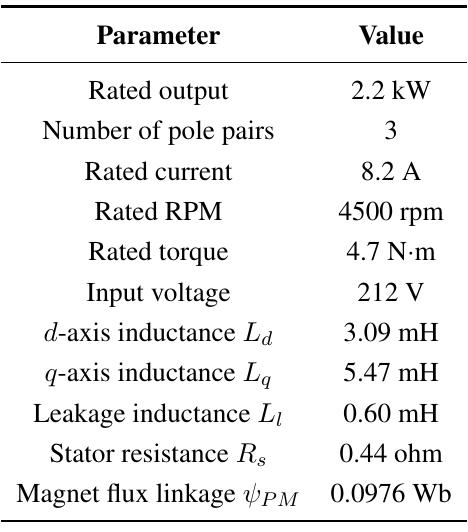
Table 1. Specifications of interior permanent magnet synchronous motor (IPMSM) used in